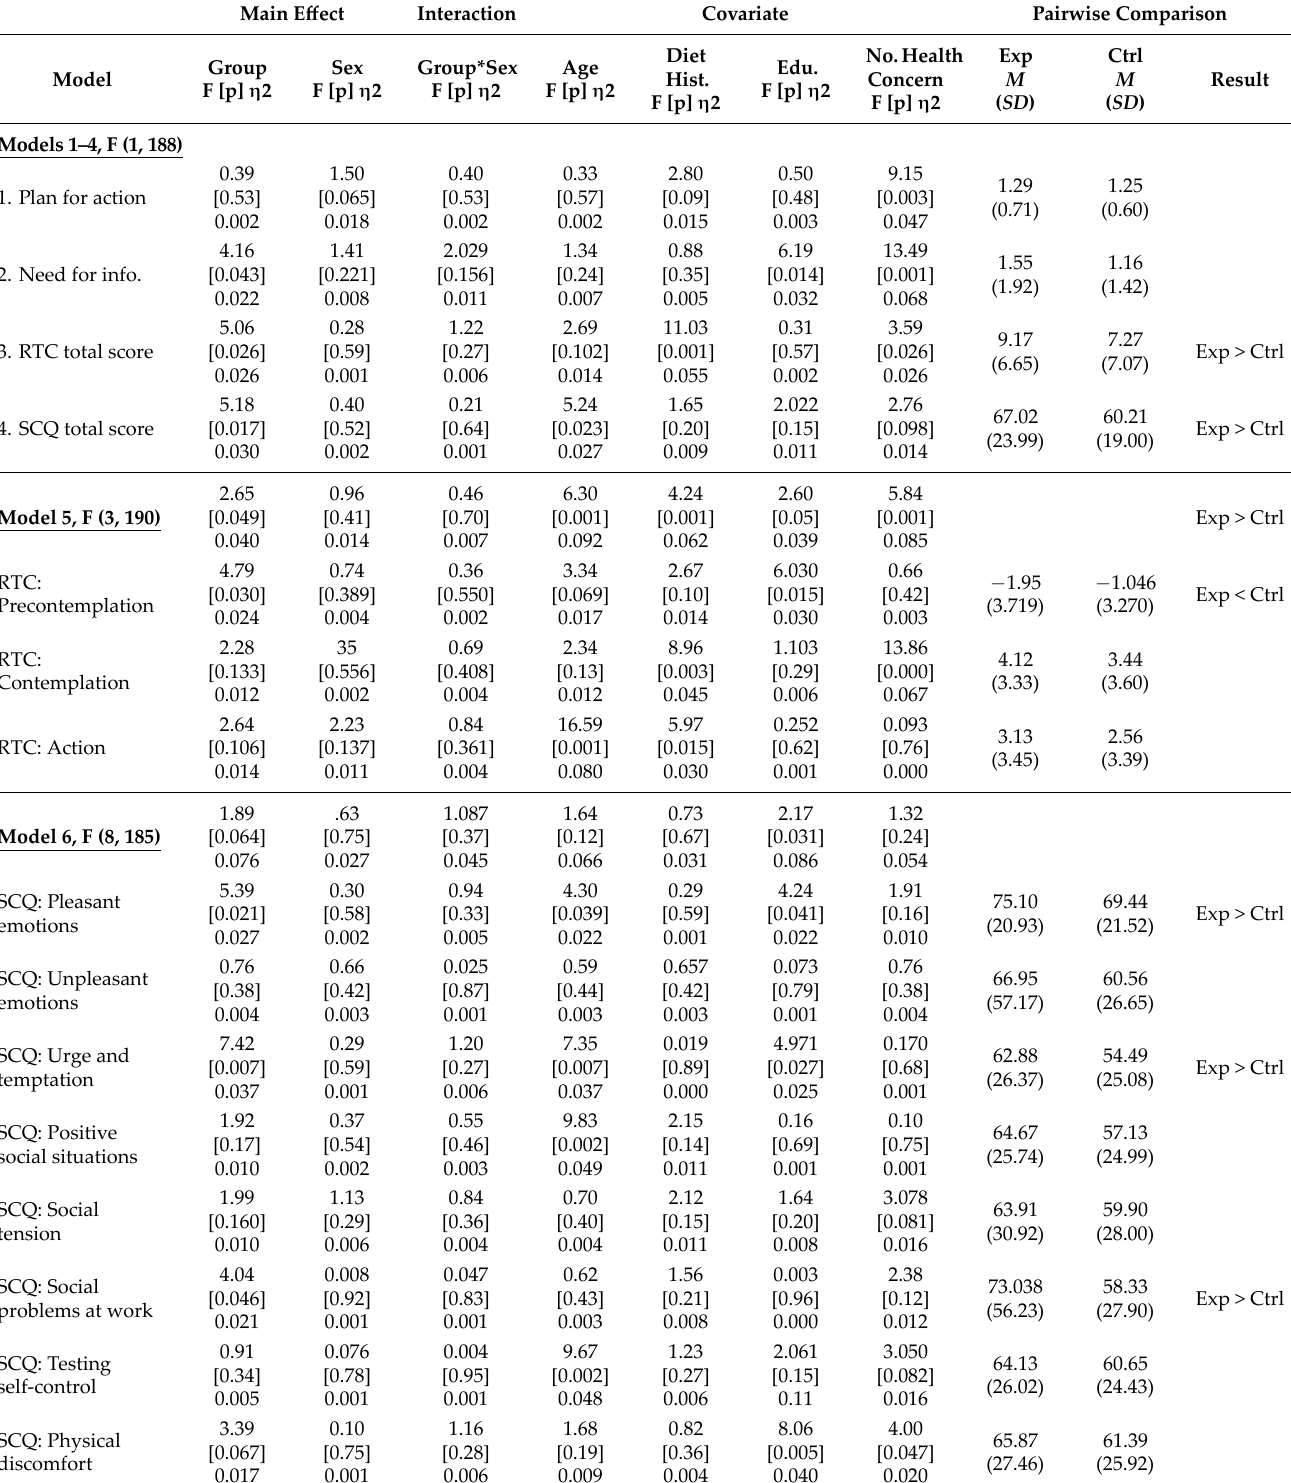
Table 6. Results of three MANCOVAs testing to evaluate the main hypothesis about the immediate effects of a brief goal commitment feedback on dieters’ need for information, plans for taking action, Readiness to Change (RTC), Situational Confidence (SC), and the RTC and SCQ